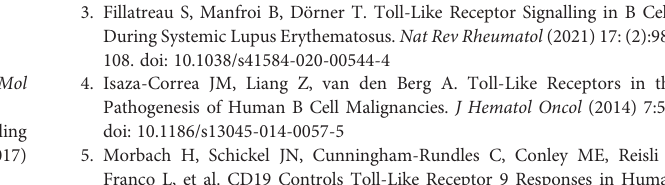
Supplementary Figure 1 | Western blot analysis of STAT3 chromatin immunoprecipitation (ChIP). Human peripheral blood B cell was treated with CpG for 24 h, then ChIP was performed using a speci fi c antibody against STAT3, followed by immunoblot detection of STAT3. b -actin was used to detect the housekeeping protein in the input and unbound fractions. Supplementary Figure 2 | Reprehensive STAT3 binding sites unique for TLR7 and TLR9 activation. Results from the ChIP-seq were visualized in Integrative Genomics Viewer, and reprehensive STAT3 target genes unique for TLR7 (A) and TLR9 (B) activation were